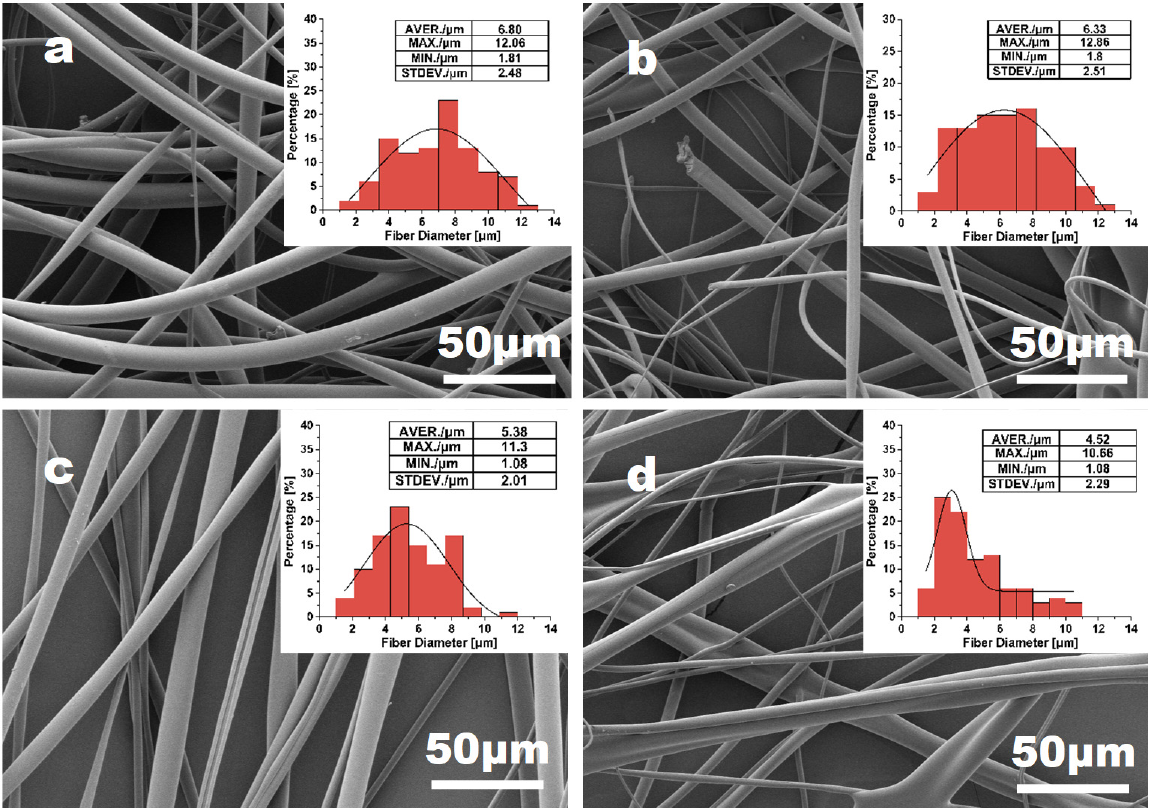
Figure 3. The effect of the nozzle size: ( a ) needle 20# (0.33 mm diameter); ( b ) needle 21# (0.41 mm diameter); ( c ) needle 22# (0.51 mm diameter); ( d ) needle 23# (0.6 mm diameter) on 15% PVA fiber morphology and the diameter distribution, with fixed parameters of rotation speed = 5500 rpm and feeding rate = 3000 mL h − 1 .